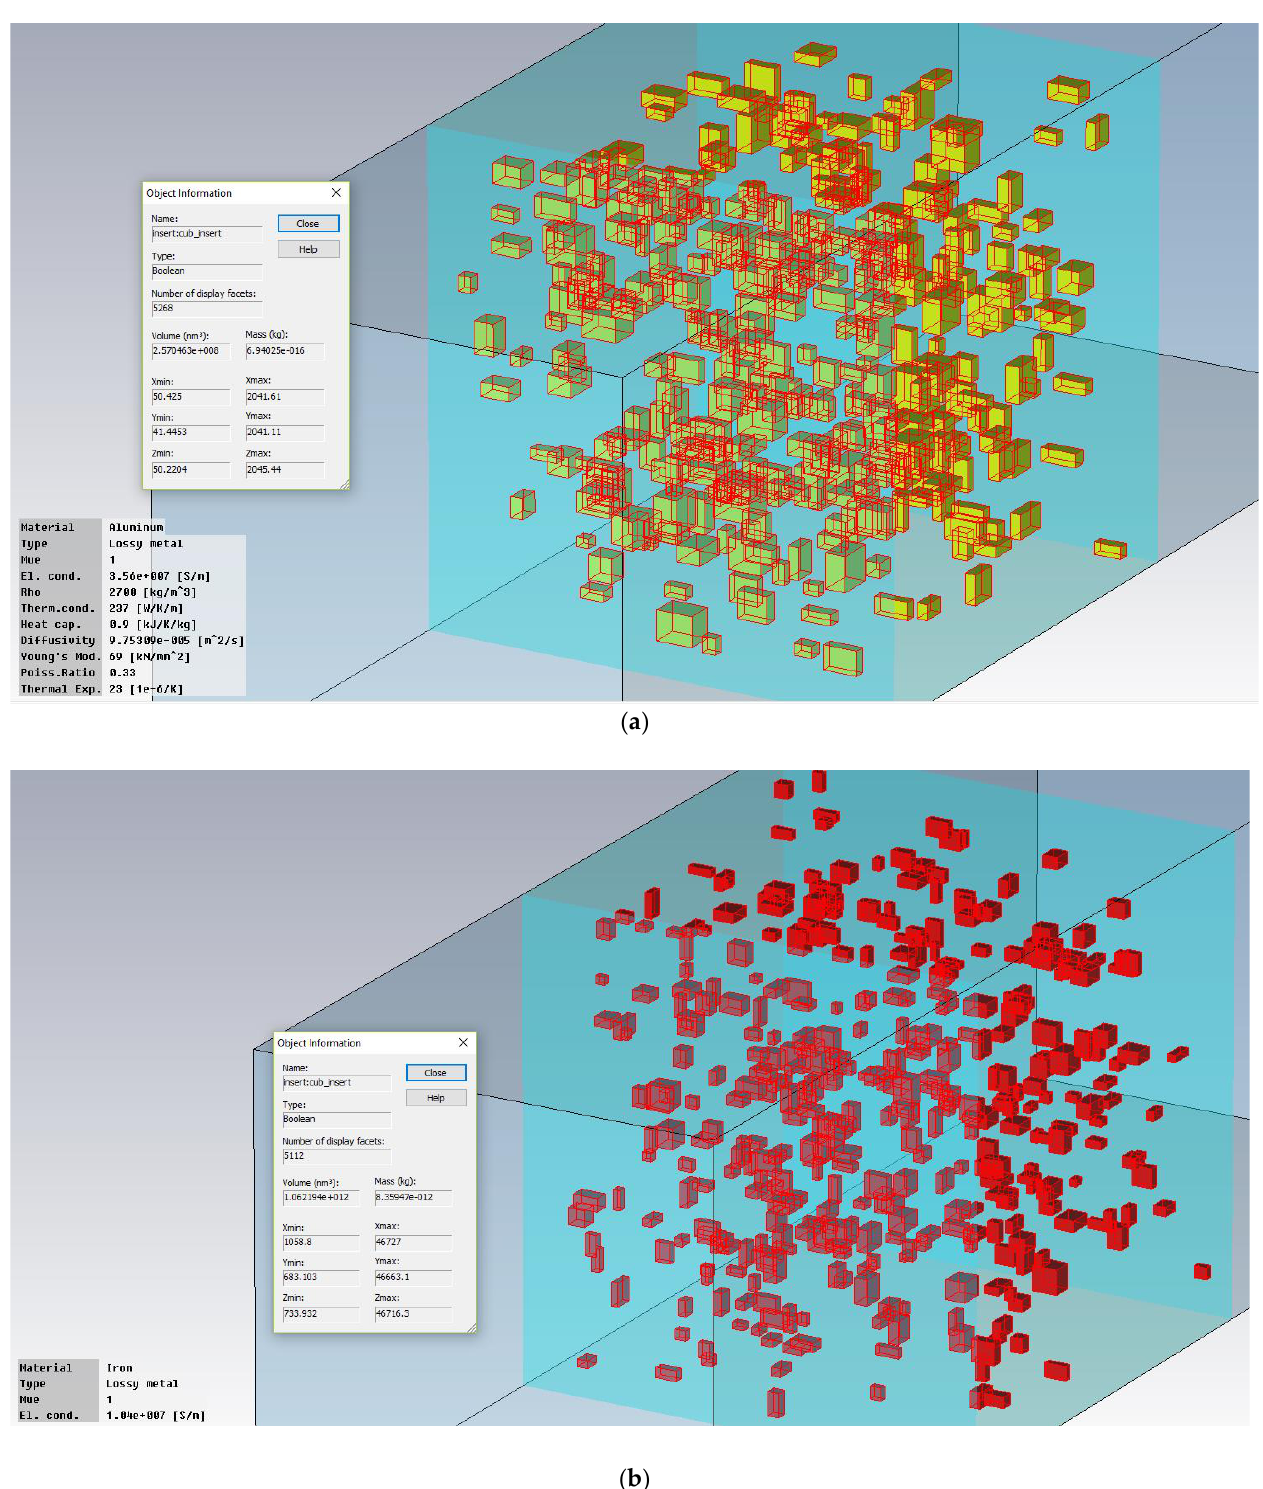
Figure 6. Simulated structures: ( a ) Al (7%) 50 nm, 394 particles, VR = 2.8048% and ( b ) Fe (7%) 800 nm, 405 particles, VR = 1.00024%.